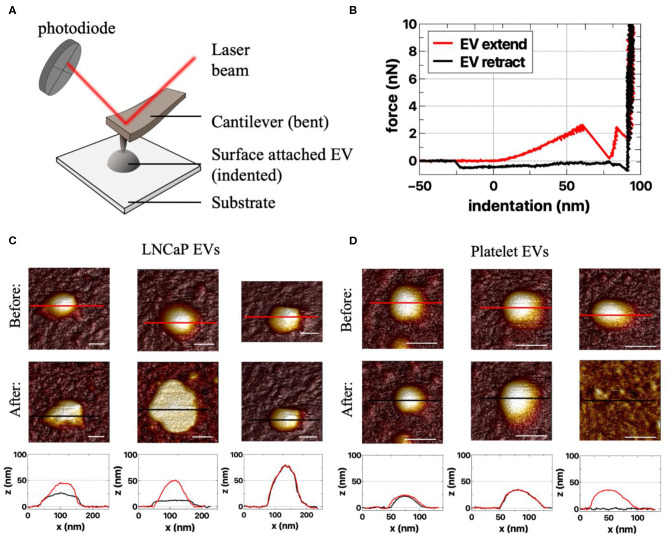
Atomic force microscopy (AFM) of extracellular vesicle (EV) samples. (A) Schematic representation of the AFM setup. In AFM, a cantilever interacts with the sample, and the reflected laser beam is detected by a photodiode (45). The experiments are performed in liquid (not depicted). (B) Example of force–indentation curves (distance z) of the extend and retract response on an EV (45). AFM images of responses of (C) LNCaP EVs and (D) platelet EVs to an applied force before (first row) and after indentation (second row). Both the LNCaP and the platelet EVs can change shape upon indentation. The different responses are illustrated by the cross-sections (bottom row), taken at the indicated spots in the corresponding AFM images above (red, before indentation; black, after indentation). Scale bars represent 50 nm.